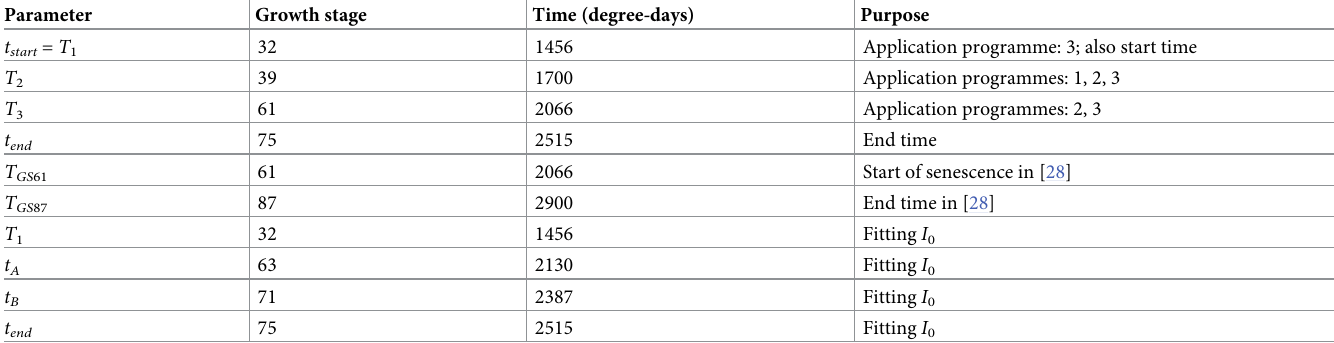
Table 2. Times that are required in running the model. Here we use Zadoks’ growth scale [47]. The times T 1 , T 2 and T 3 are as in [28, 36]. The start time is growth stage 32, corresponding to the emergence of leaf 3 ( T 1 ). The final time t end (growth stage 75) is interpolated from the value at growth stage 61 ( T GS 61 = T 3 = 2066 degree-days) and growth stage 87 ( T = 2900 degree-days) from [28, 36]. This assumes that the temperature remains approximately constant in the late stages of the season. We also GS 87 round the values to the nearest integer. Growth stage 75 was chosen for the end time because it was the time in Dataset D which links yield to disease severity (Table 3). Any host or pathogen growth before t can be scaled into the amount of inoculum I 0 in the model at t ; the procedure used to fit the initial inoculum parameter, I 0 , is start start reported in S1